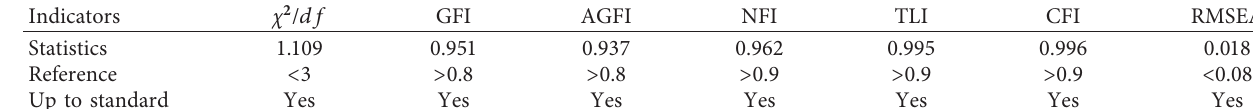
Table 5: Fitting index of structural equation model.